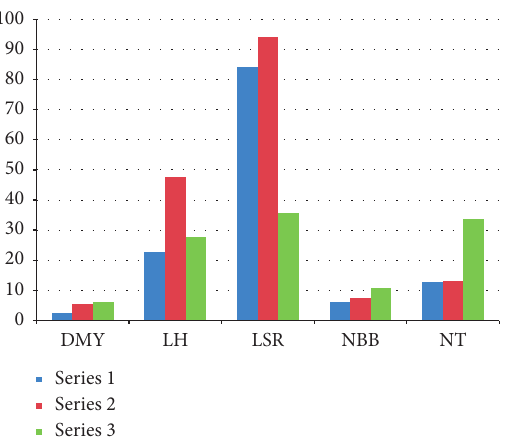
Figure 1: Agronomic traits over three years. DMY � dry matter yield (t/ha); LH � leaf height (cm); LSR � leaf to stem ratio; NBB � number of leaves per plant; NT � number of tillers; series 1 � planting year 1; series 2 � harvesting year 2; series 3 �